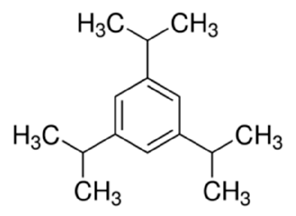
Figure 6. 1,3,5-Triisopropyl benzene molecule.